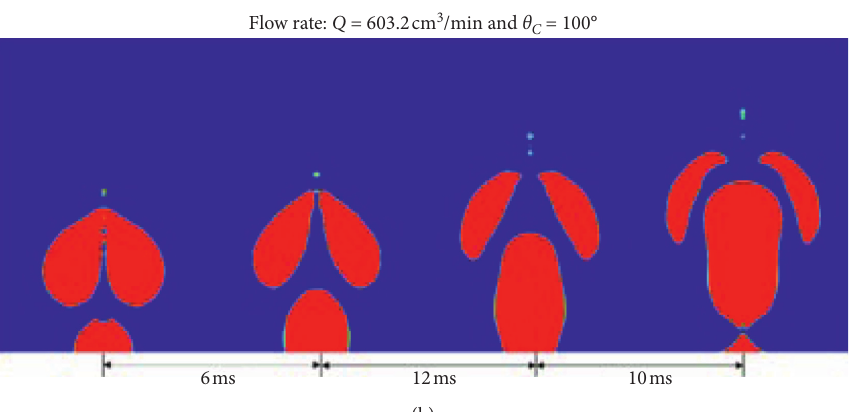
Figure 14: Comparison of the formation process of the first bubble in Figure 15 between dynamic and static contact angle ( Q � 603.2cm 3 / min, Re � 219.07, and d a � 4mm): (a) snapshots by using the dynamic contact angle model; (b) snapshots by using the static contact angle